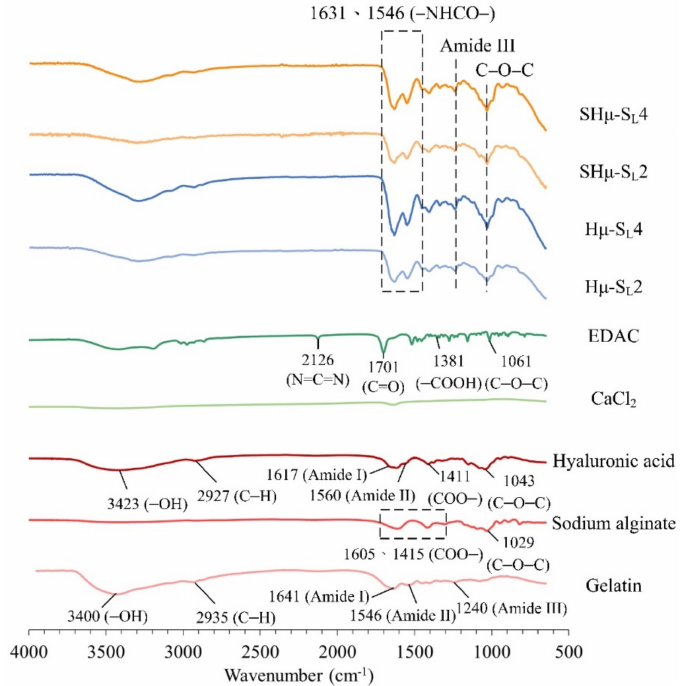
Figure 4. Spectra of the used hydrogels and the different prepared scaffolds cross-linked with EDAC and CaCl 2 .